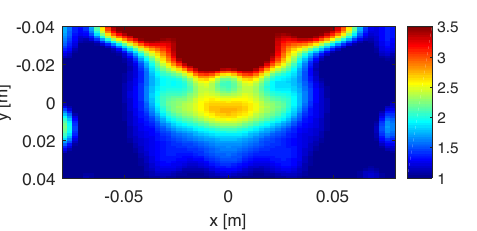
( c ) Reconstruction using the omnidirectional incident field for the circular sector measurement